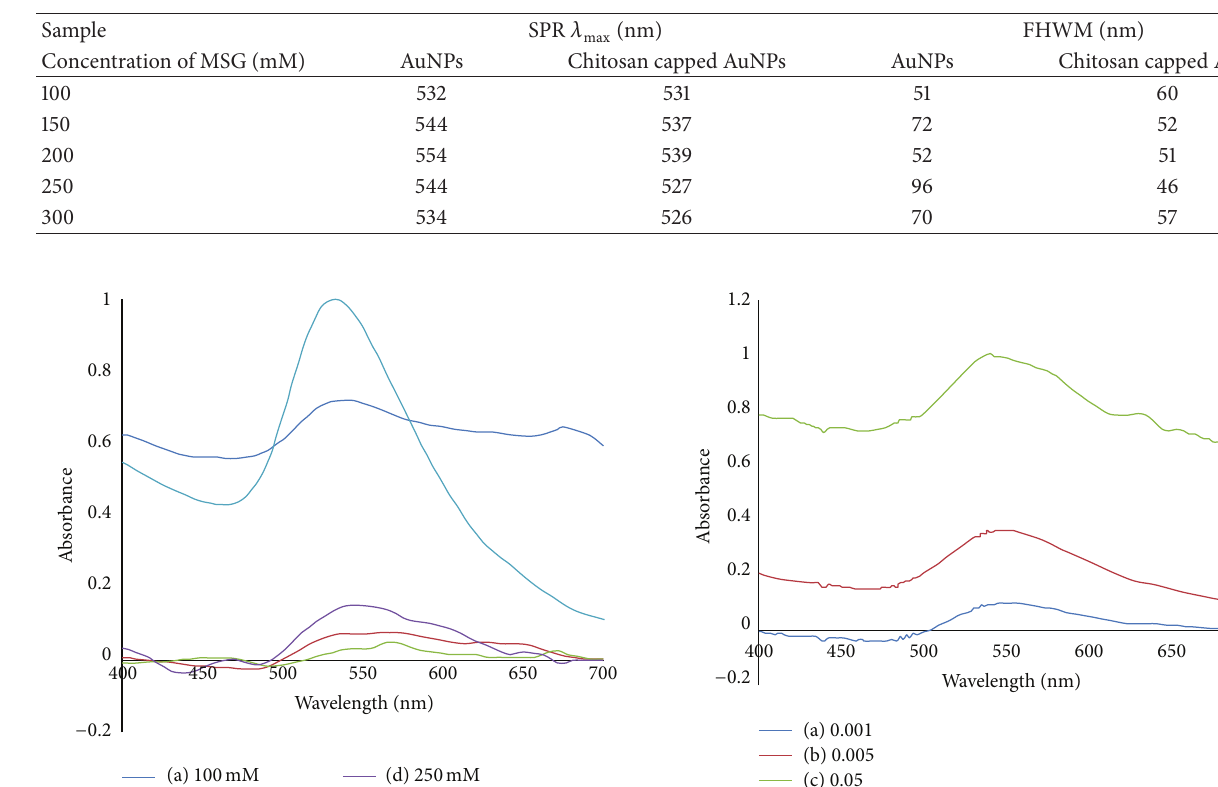
Table 1: Experimental values of SPR peaks for bare and chitosan capped AuNPs with full width half maximum (FWHM) after 1 month ageing time.